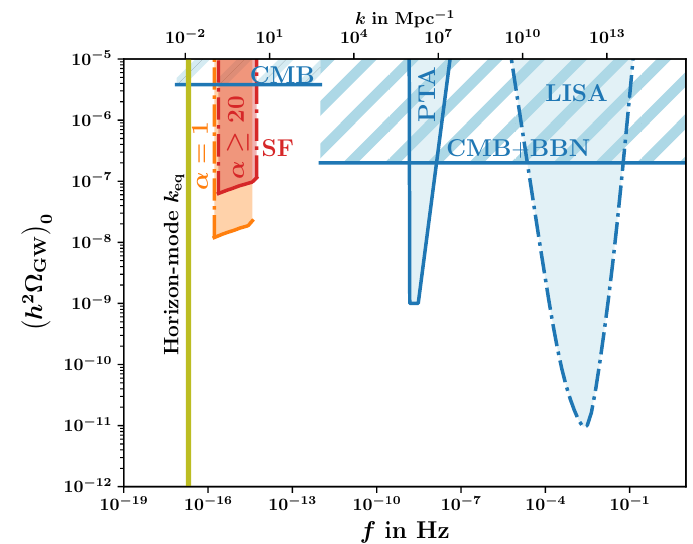
Figure 13: The GW abundance today as a function of today frequency. Shown are the projected bound by LISA [ 2 ] (dashed-dot blue), the bound set by PTAs [ 64–67 ] (solid blue) and the indirect bounds from CMB and BBN [ 68–70 ] (hatched areas). As the result of our calculation, the red colored regions are excluded by structure formation. However, many assumptions went into our calculation so the bound should be taken with